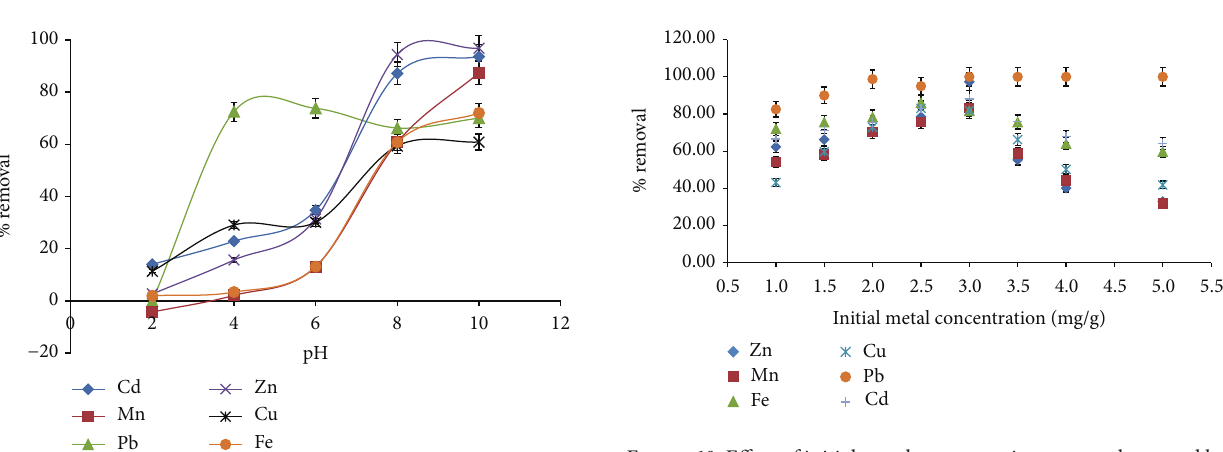
Figure 10: Effect of initial metal concentration on metal removal by MSP.